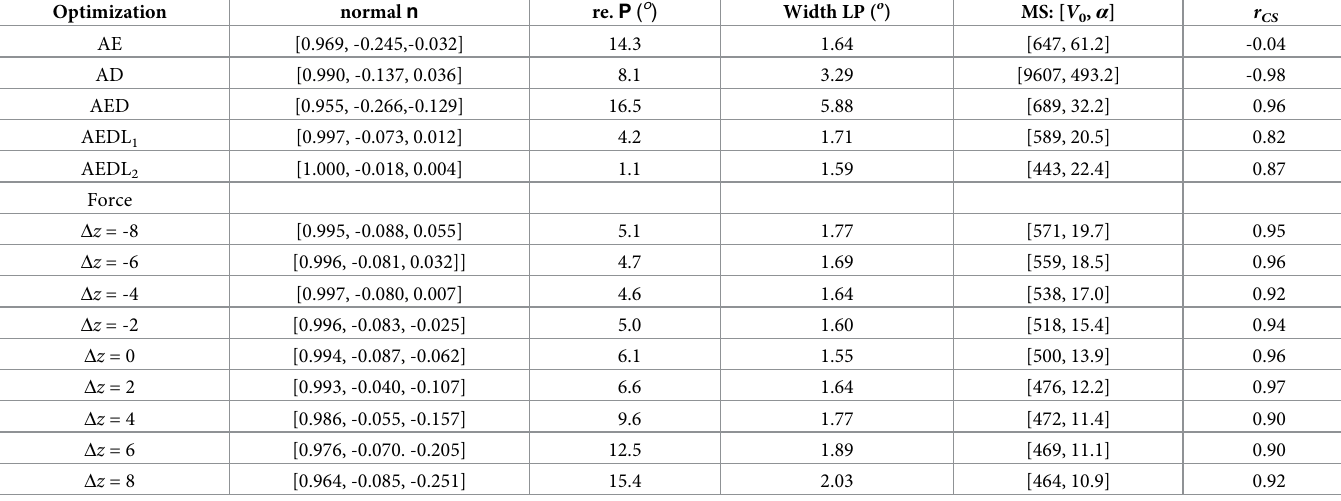
Table 3. Results for the different optimization strategies specified in Table 2. n : normal to the best-fit plane through the rotation-vector data, and absolute angle between n and the straight-ahead direction, P = [1, 0, 0]; Width LP: standard deviation of the data around the best-fit plane. MS: nonlinear main-sequence data fit on all